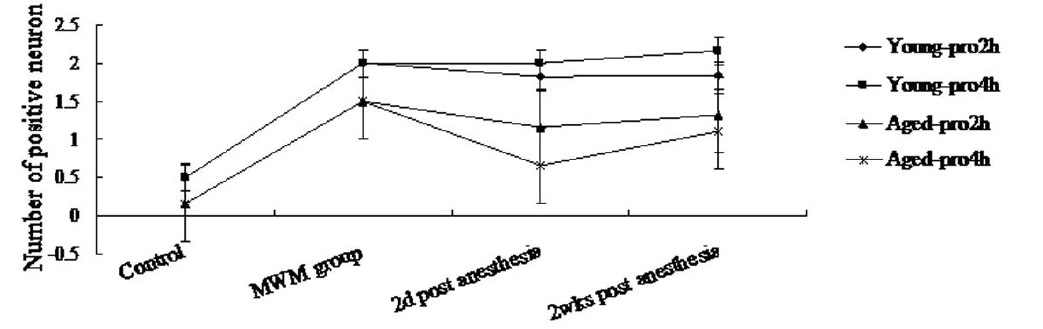
FIGURE 6 - Effect of propofol anesthesia on the expression of PKC. No PKC were seen in the hippocampal CA1 area of both young and aged rats. In MWM groups of all rats, number of PKC positive neurons in this area was significantly increased (P < 0.05), which was not affected by propofol exposure in young rats and aged rats in group P4h/2w (P>0.05). The expression of PKC was depressed in aged rats of group P4h/2d comparing with those in MWM group (P <